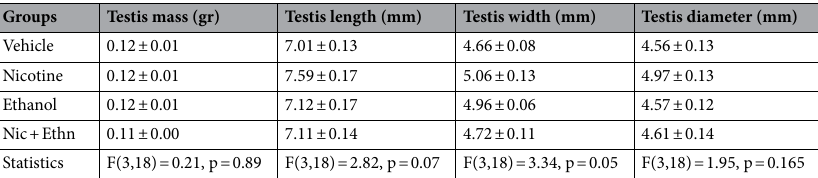
Table 1. The effects of exposure to nicotine and ethanol, either alone or simultaneously, during in utero life and breastfeeding periods on testicular weight and